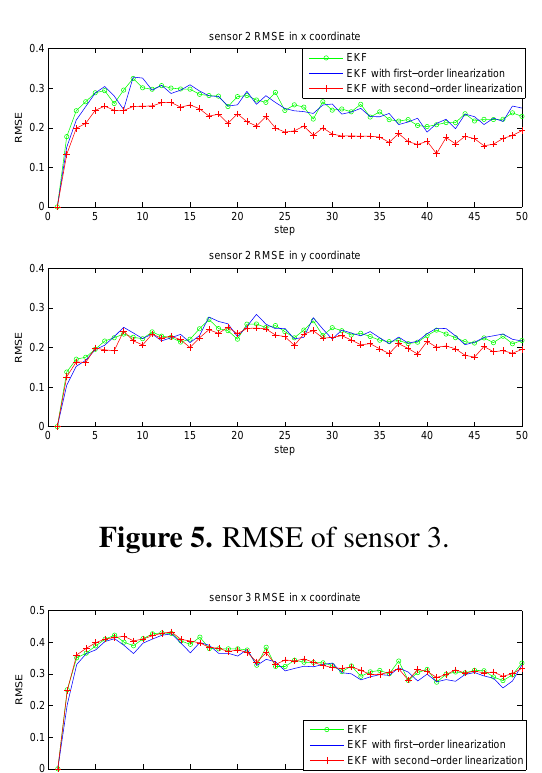
Figure 4. RMSE of sensor 2.